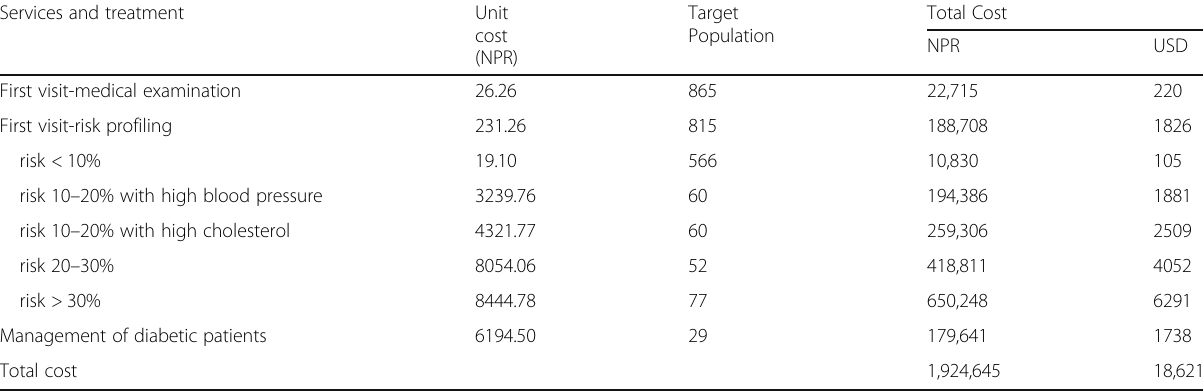
Table 6 Annual cost of treatment for a population of 10,000 people at 50% coverage Services and